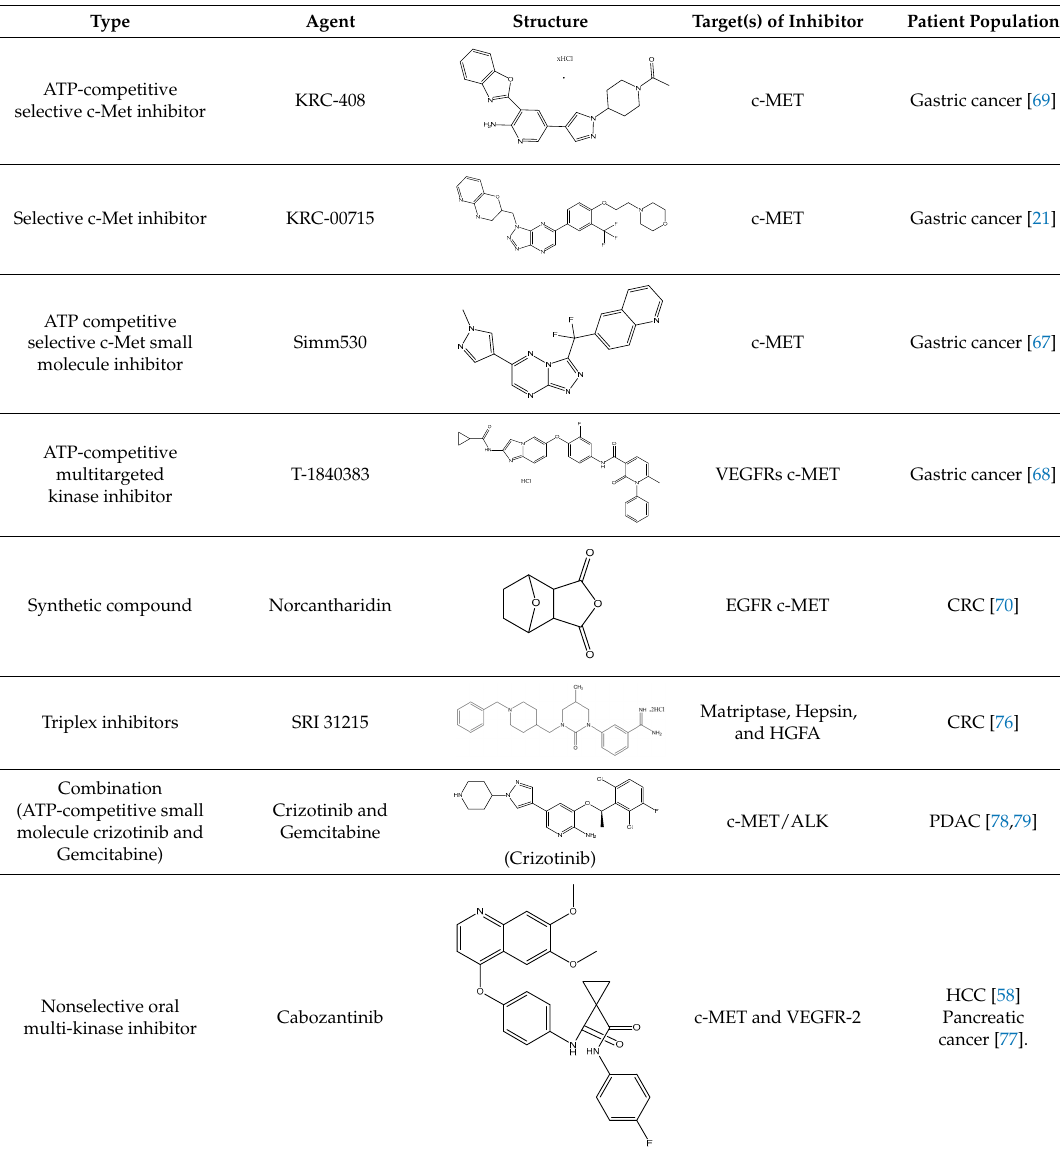
Figure 2. Targeting HGF/c-MET pathway in digestive system cancers by microRNAs. ( A ) targeting HGF/c-MET in HCC by miRNAs; ( B ) miRNAs-HGF/c-MET axis in gastric cancer; ( C ) miRNAs- HGF/c-MET axis in CRC; ( D ) miRNAs-HGF/c-MET axis and pancreatic cancer. Abbreviations: EMT, epithelial–mesenchymal transition; ACS, adenoma–carcinoma sequence. directly target; induction. 9. Targeting HGF/c-MET in Hepatocellular Carcinoma (HCC) by miRNAs The miRNA dysregulation is causal in many human cancers including HCC [81]. Because of the strong association between HGF/c-MET activation and human cancers, targeting HGF/c-MET by miRNAs may be a promising approach for cancer treatment (Figure 2) [30]. Yang et al. found